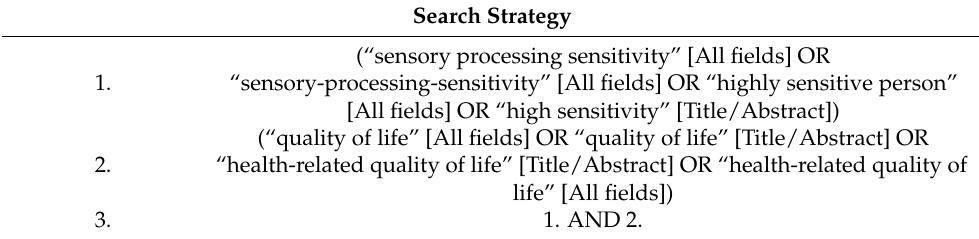
Table 1. Database search